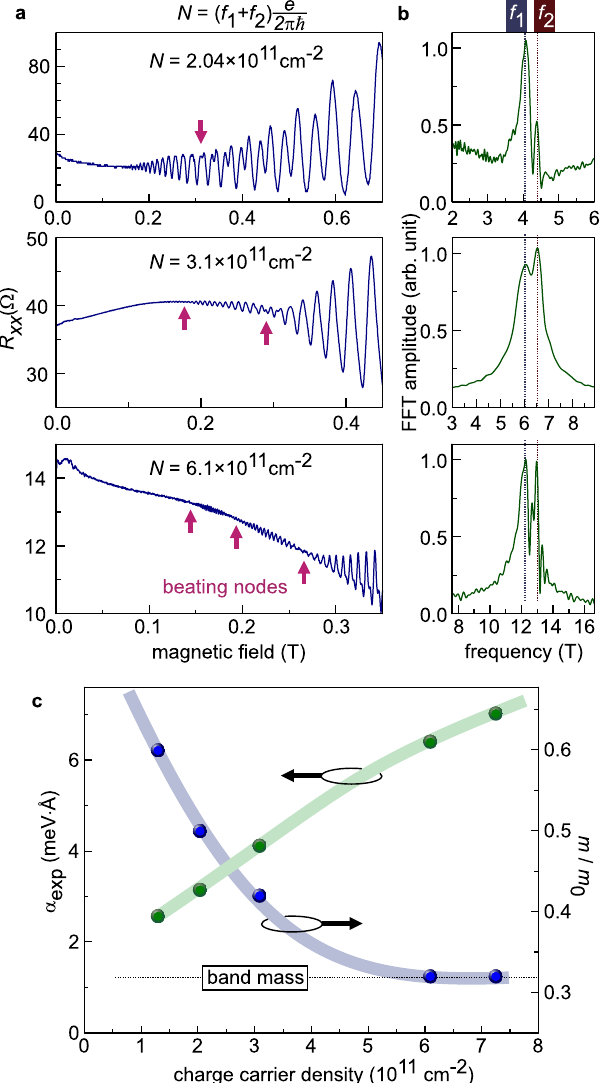
Fig. 2 Electron density dependence of spin – orbit coupling effect and Coulomb interaction. a In low magnetic fi eld Shubnikov-de Haas effect reveals the beating pattern of quantum oscillations in a wide range of charge carrier density N . The arrows indicate the beating nodes. b Fast Fourier transformation reveals two dominating oscillation frequency components. c Spin – orbit coef fi cient (left axis) extracted according to Eq. (2) from the Fourier spectrum shown in panel b depends on the charge carrier density. The electron effective mass (right axis, m 0 is the free electron mass) increases with decreasing electron density and points to Fermi-liquid-like behavior. ZnO is thus a system showing an interplay between SOC effect and Coulomb interaction effect.